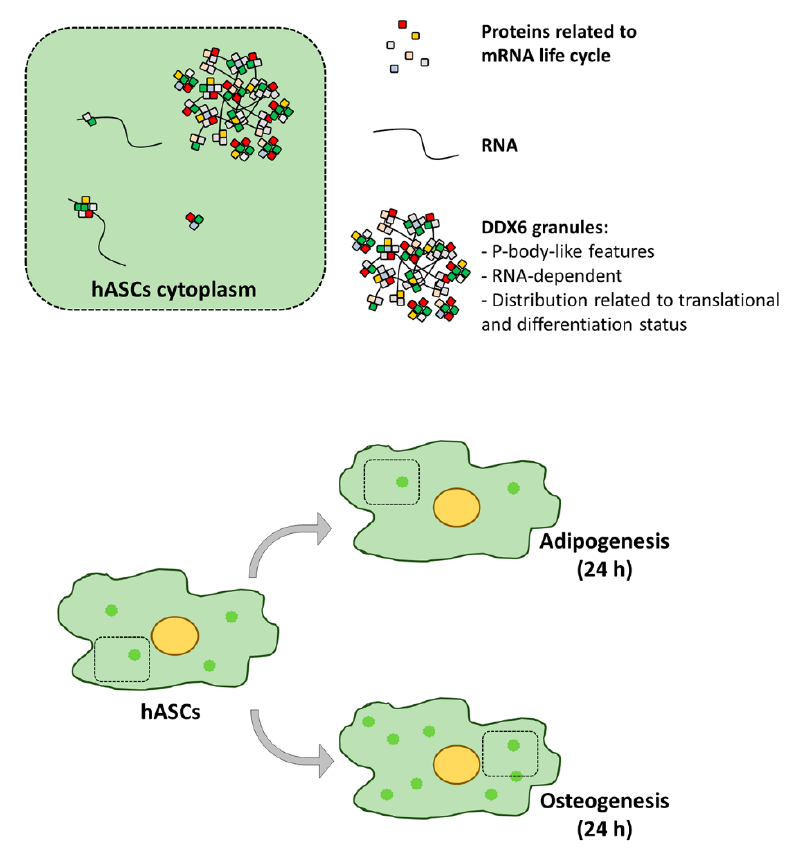
Figure 7. DDX6 complex composition and distribution in the hASCs that were not induced and those induced to adipogenesis or osteogenesis for 24 h.